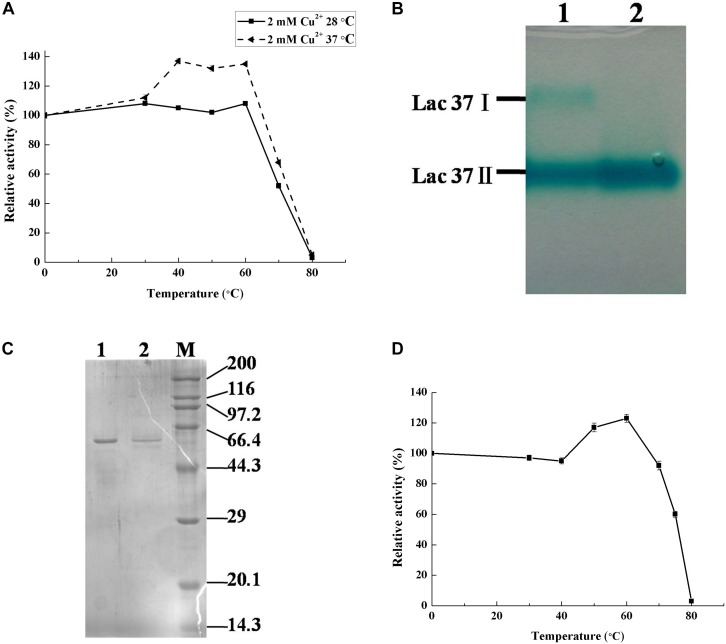
Thermo-activated analysis and purification of laccase from T. trogii S0301. Native-page (B) and SDS-page (C) analysis. Lanes 1 and 2 are the crude and purified laccase produced at 37°C, respectively. The crude laccase activity of the culture filtrate produced at 37 and 28°C were 3330.62 and 4861.11 U L–1
(A). Thermo-activated analysis of purified Lac 37 II from 37°C, which the original activity is 343.06 U mg–1
(D). Activity is represented as % relative to the not heat-treated, assigned as 100%. Data points are the average of triplicate measurements, and the error bars represent the standard deviation.